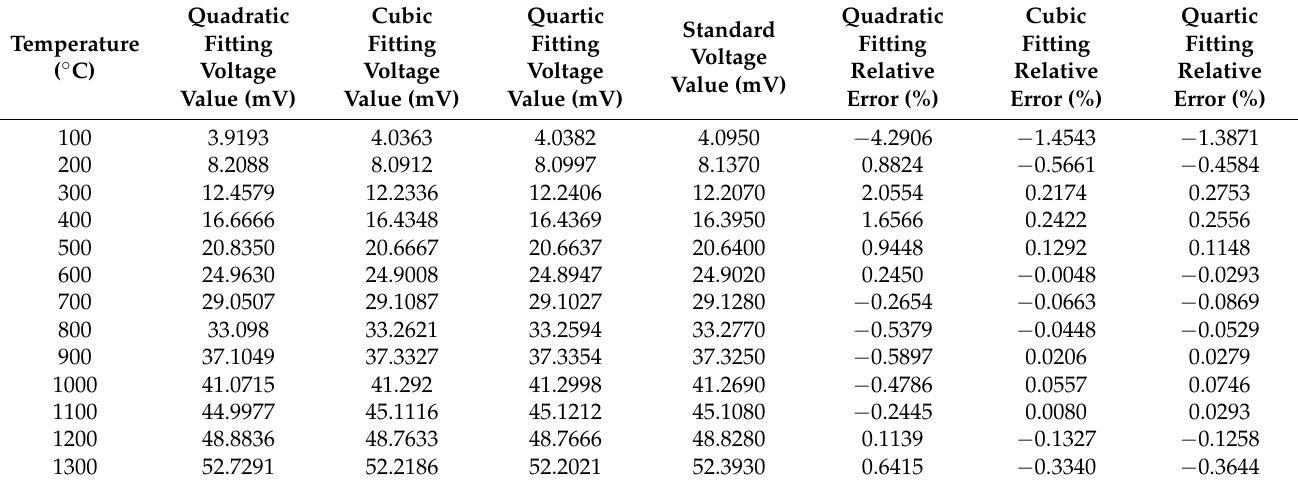
Table 1. Comparison of fitting equations of the standard